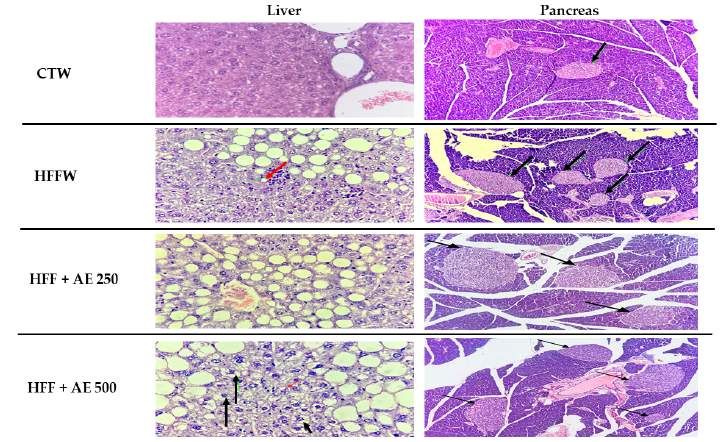
Figure 7. Histological analysis of the liver (red arrow indicates lobular inflammation, and black arrows indicate ballooning), 400× magnification, bar scale: 100 µm and pancreas (black arrows indicate Langerhans islets), 100× magnification, bar scale: 100 µm of CTW (CT + drinking water), HFFW (high-fat/high-fructose diet + drinking water), HFF + AE 250 (HFF + M. citrifolia fruit aqueous extract of 250 mg/kg of body weight), HFF + AE 500 (HFF + M. citrifolia fruit aqueous extract of 500 mg/kg).